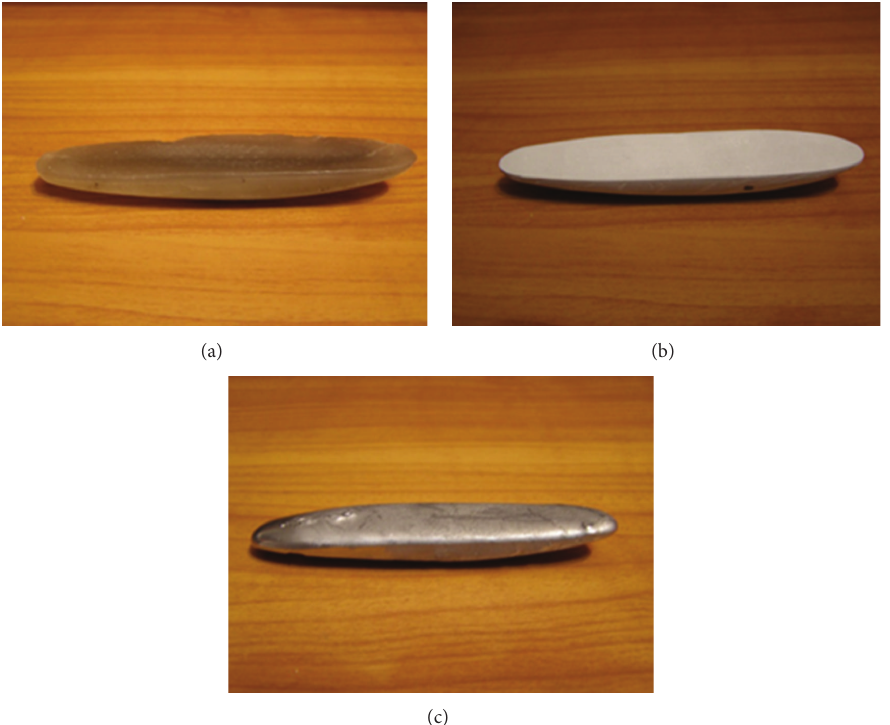
Figure 2: The three rattleback prototypes made of (a) wax, (b) gypsum, and (c) lead-solder.